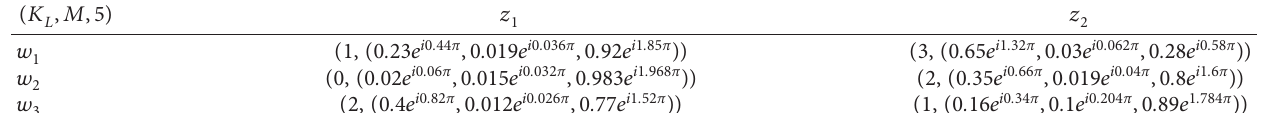
Table 12: Tabular representation of restricted intersection ( K